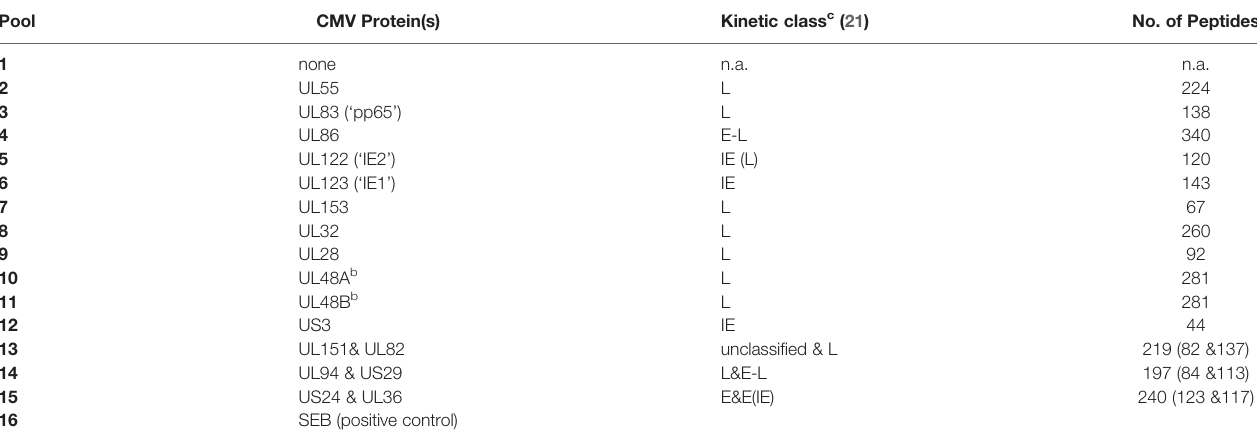
TABLE 1 | CMV protein-covering peptide-pools used for T-cell stimulation a